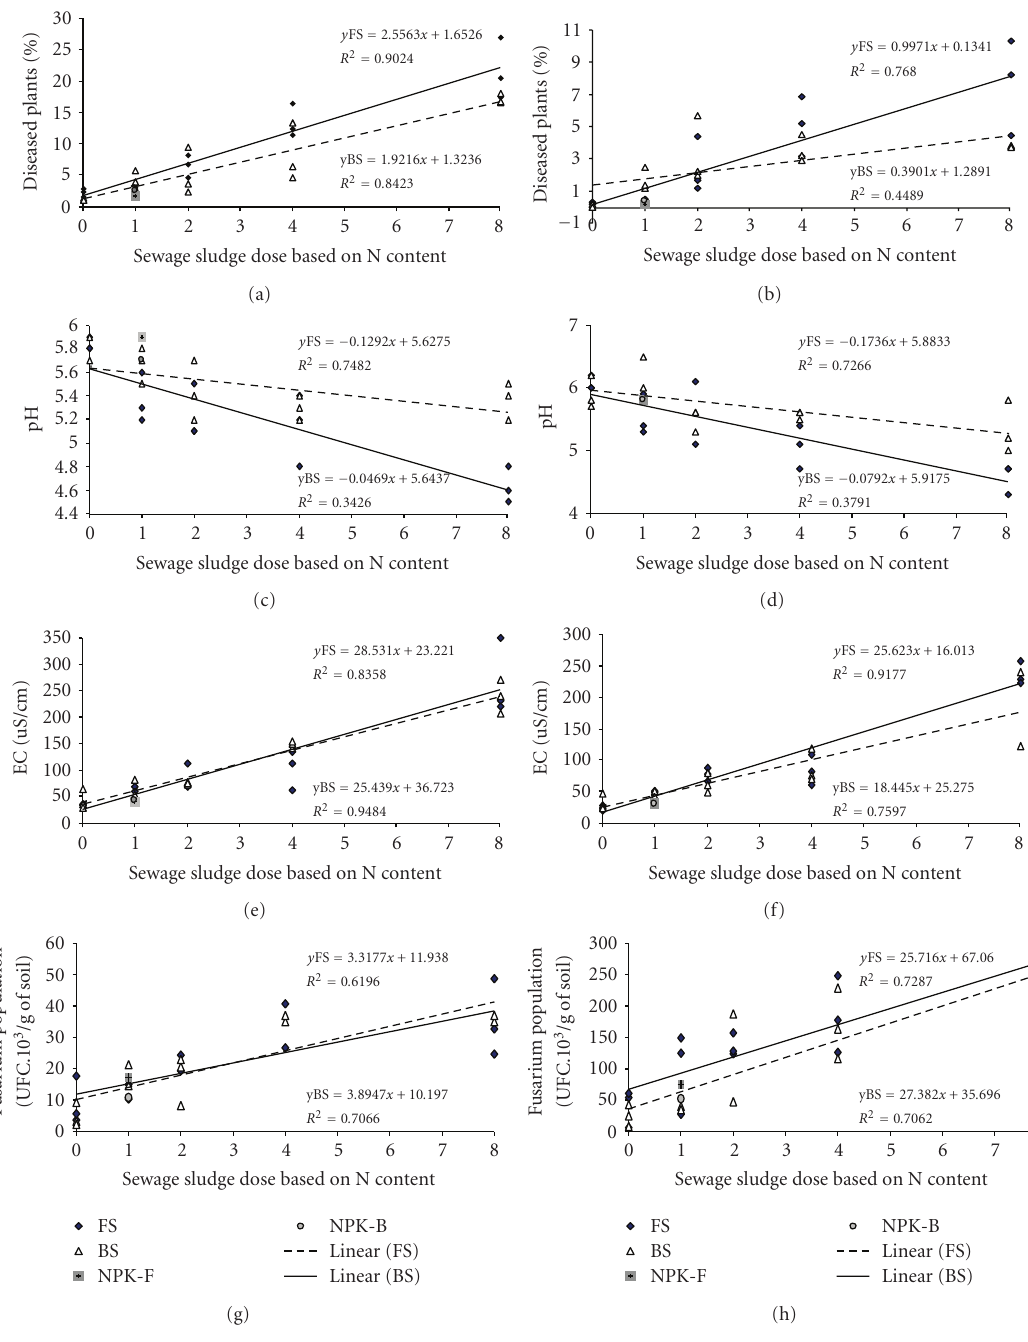
Figure 1: E ff ect of sewage sludge rates (FS: Franca sludge; BS: Barueri Sludge; NPK-F: recommended mineral fertilization compared to Franca sludge; NPK-B: recommended mineral fertilization compared to Barueri sludge) over the percentage of diseased plants, pH and electric conductivity of the soil, and Fusarium population in the soil. Left column contains data referring to second planting; right column refers to third planting. Bettiol